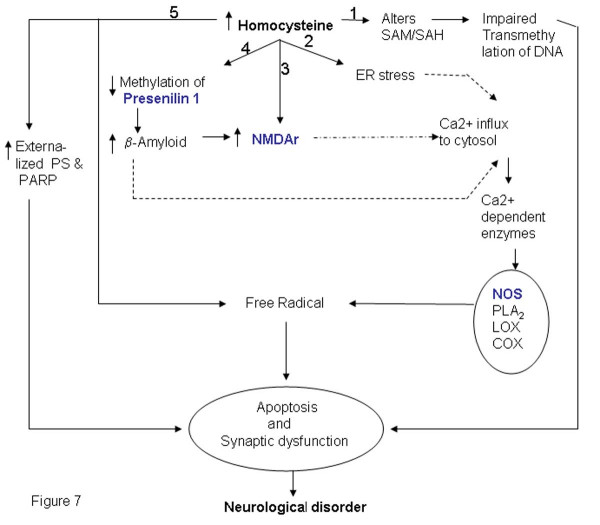
Pathways that link elevated homocysteine level with Neurological disorders. Elevated homocysteine levels may cause neurological diseases by various mechanisms which include), altered methylation (branch 1 & 4), ER stress (branch 2), direct interaction with receptors (branch 3) and biomarker of apoptosis (branch 4). The Symbols shaded in color are the gene names given included in the gene-list. The genes marked in blue have been identified by literature based searches as mentioned in the methods section. The solid and dotted lines indicate direct and indirect (multi step) interaction/ conversion respectively.